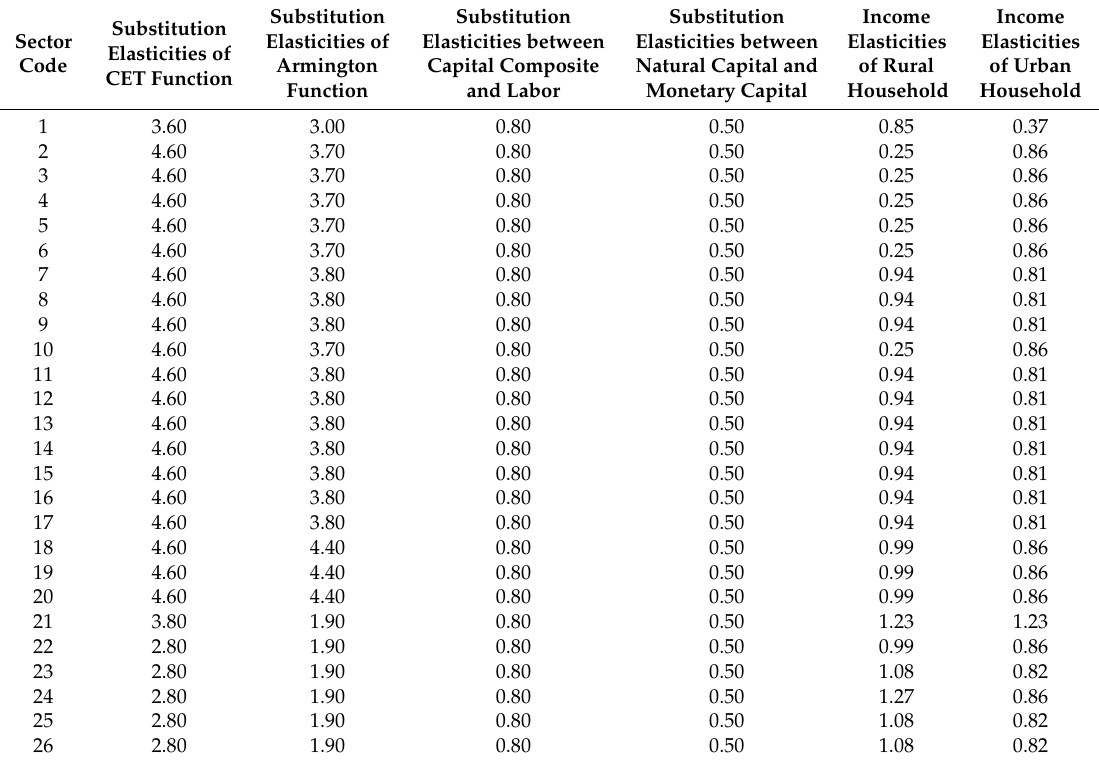
Table 2. Value of elasticity parameters of the